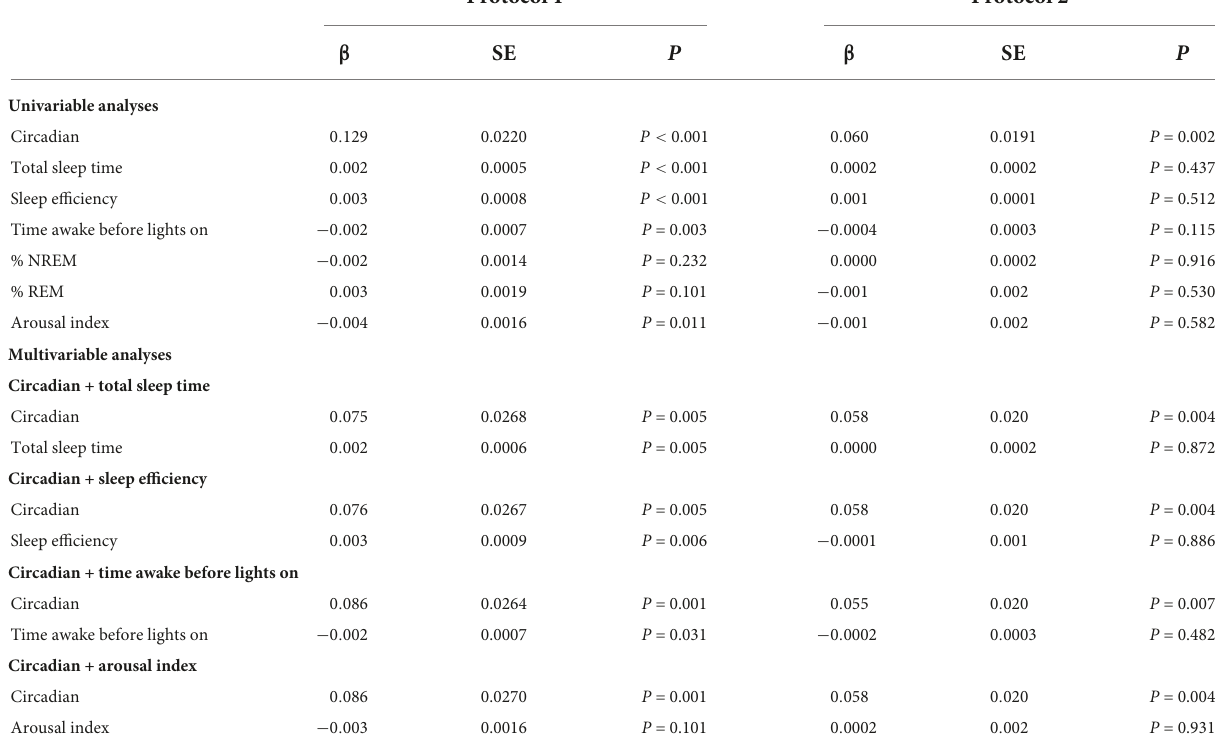
TABLE 2 Univariable and multivariable mixed models for the circadian and sleep effects on the cortisol awakening response (CAR) in two distinct protocols. Protocol